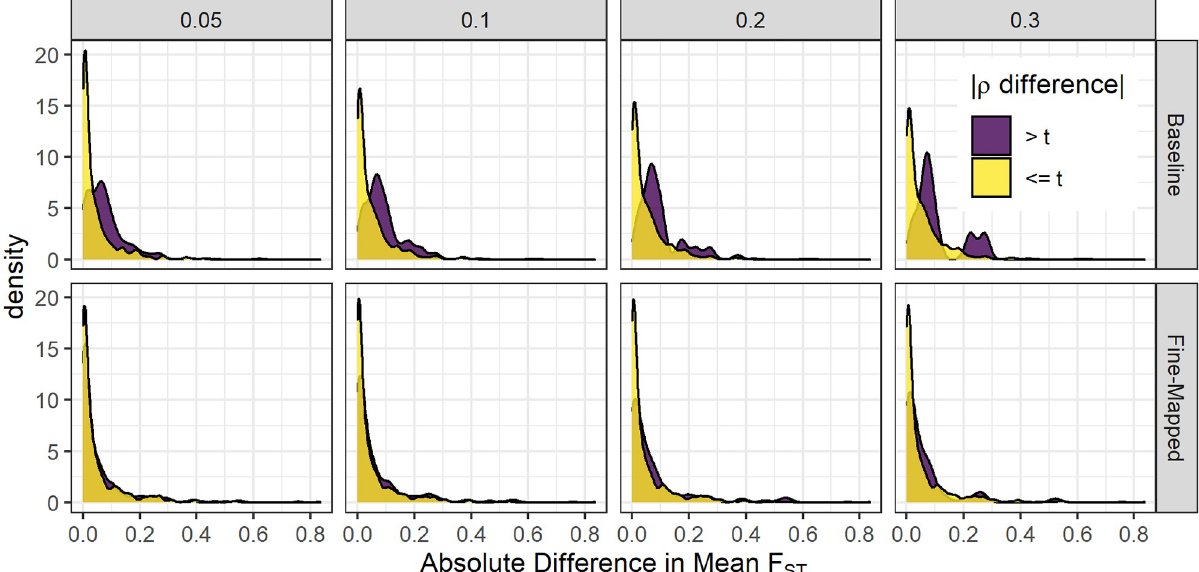
Fig 4. Allele frequency differences lead to protein predictive performance differences between populations. Comparison of mean F ST differences between protein models with large ( > t ) and small ( < = t ) differences in predictive performance ρ in INTERVAL. For baseline models, protein groups with the larger absolute value ρ difference between TOPMed MESA training populations had significantly larger mean F ST at each difference threshold, t (Wilcoxon rank sum tests, p < 3.1 × 10 − 10 ). For fine-mapped models, the differences between protein groups were attenuated, but still significant when t = 0.1 ( p = 0.0028) and t = 0.2 ( p = 0.010).